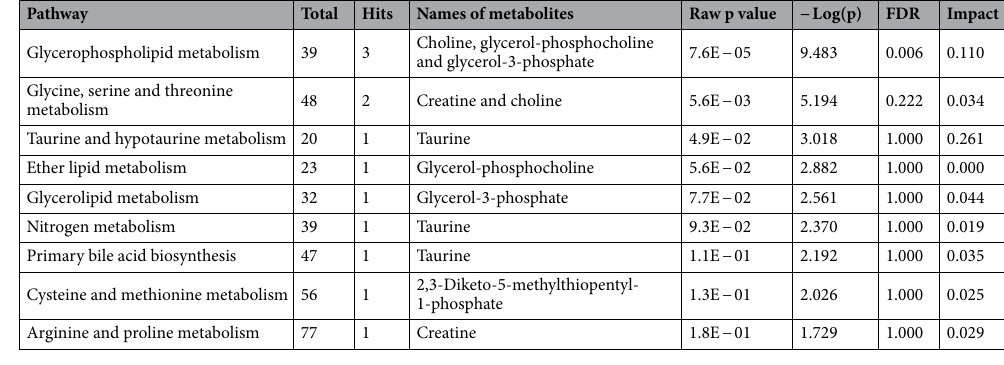
Table 3. Metabolic pathway enriched for the significantly changed metabolites following miRNA transfection. Fisher’s exact test was applied for the enrichment analysis, and Degree Centrality was chosen for the topology analysis. p-values for each matched pathway was calculated from the pathway enrichment analysis (threshold was set to 0.05 following FDR correction), and the impact-value was calculated from the pathway topology analysis (threshold was set to 0.10). Hits refer to the number of metabolites identified in our study out of the total number of metabolites within a given